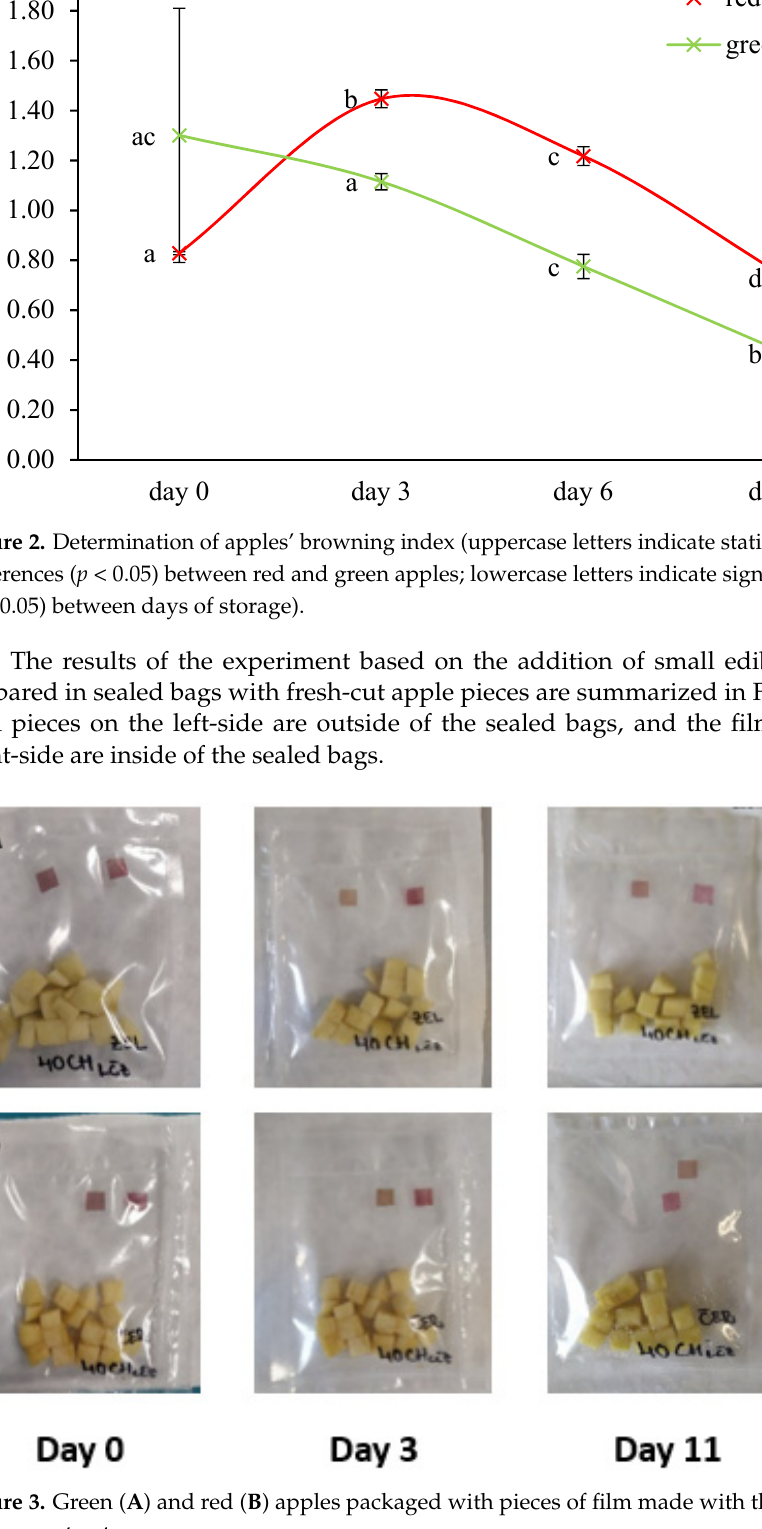
Figure 4. Green ( A ) and red ( B ) apples packaged with pieces of film made with the addition of blue tea.